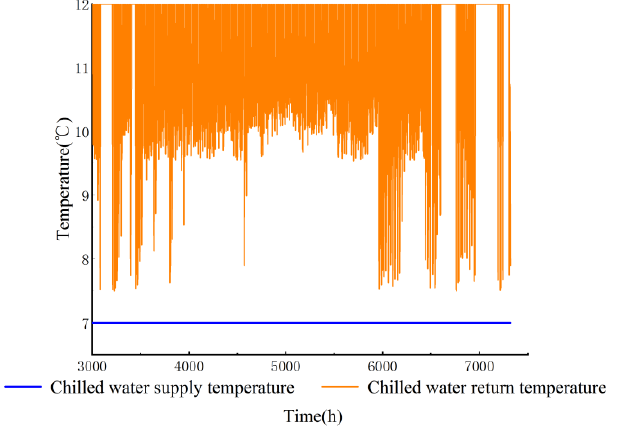
Figure 10. Supply and return water temperature at load side without optimization.